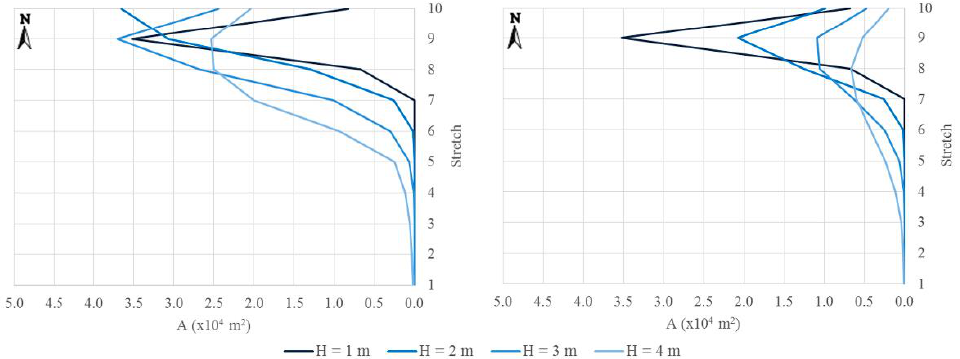
Figure 10. Area gained due to artificial nourishment after the fifth year of simulation ( θ = 85 ◦ ): Clo/Clo ( left ); Ext/Ext ( right ) (based on [41,42]).